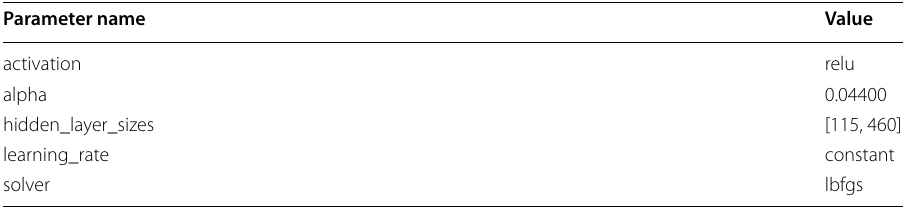
Parameter values for classifier yielding best results in terms of AUPRC Table 100 Modes of MLP tuned hyperparameter values for experiments with the keylogging dataset